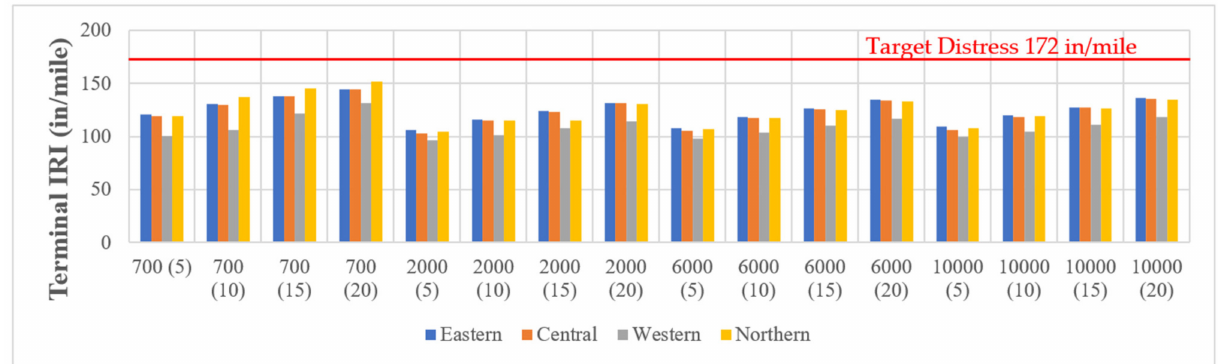
Figure 12. Terminal IRI (in/mile) for an interval of 5, 10, 15, and 20 years.